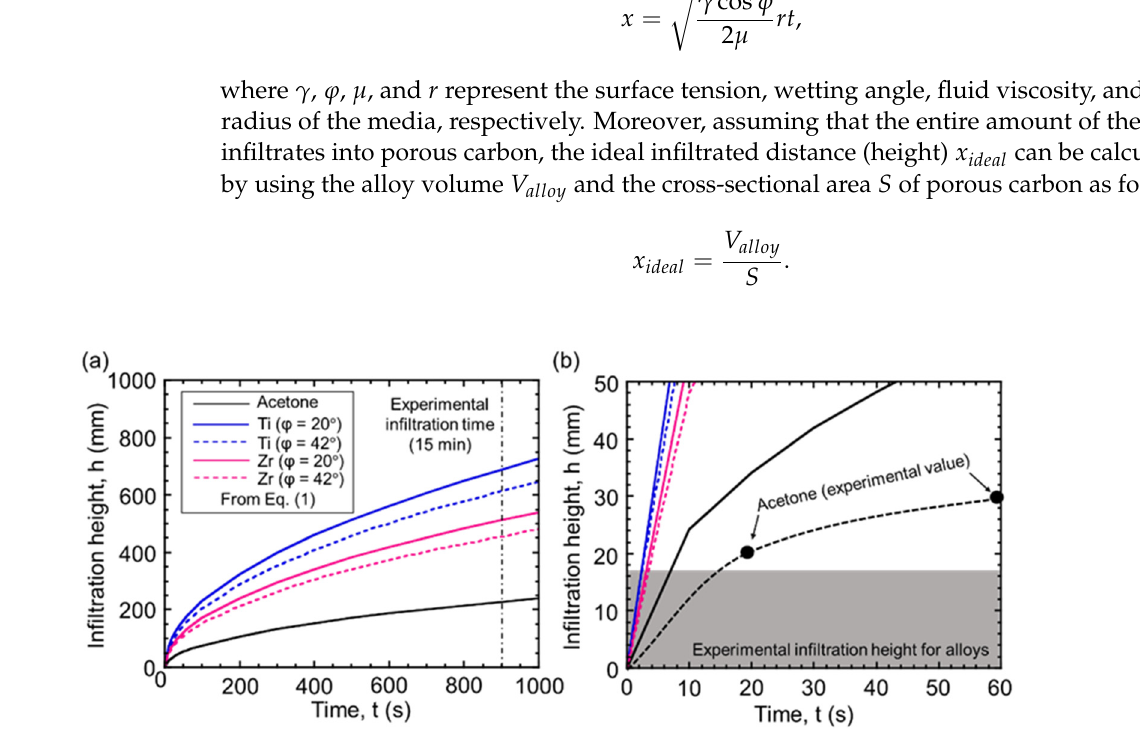
Figure 4. Macroscopic SEM images of infiltrated model preforms. Here, “×” represents the infiltra- tion height.